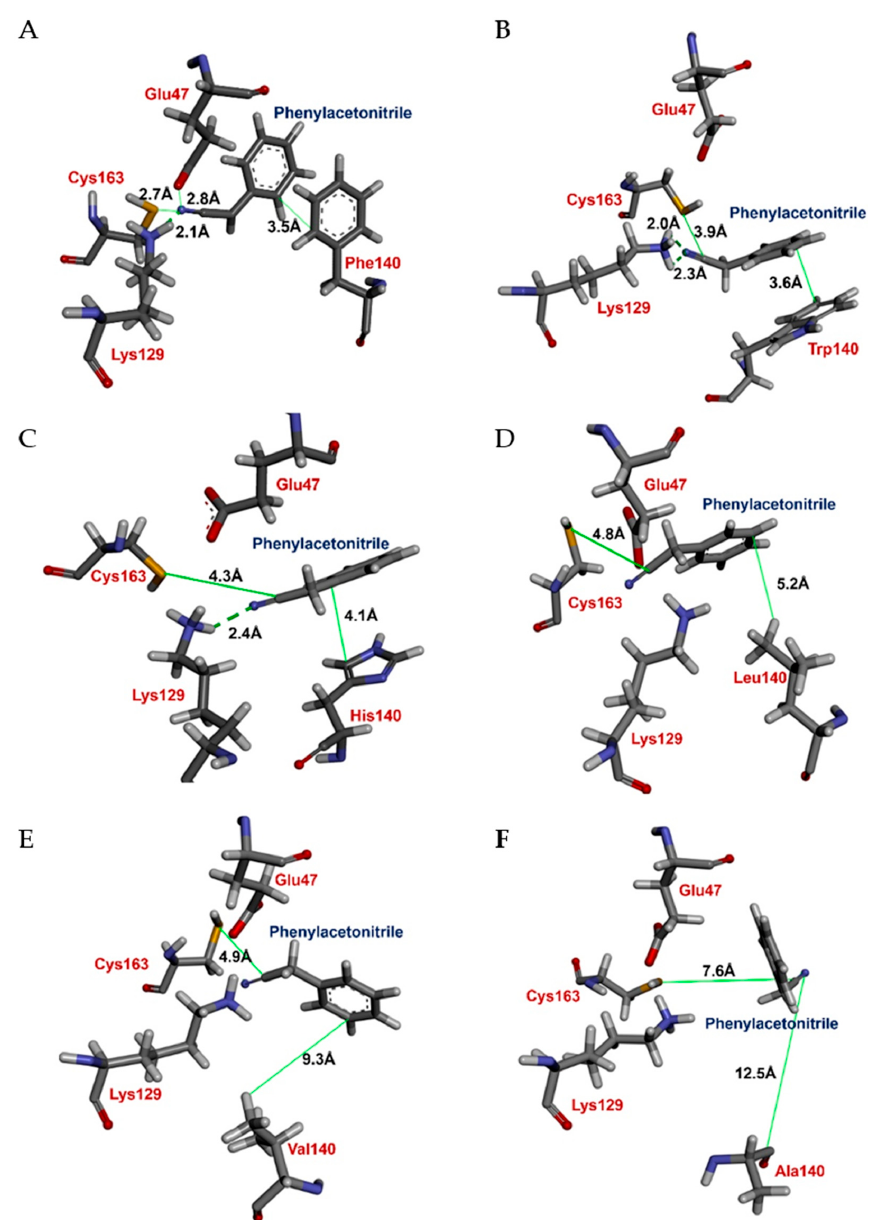
Figure 6. Model image of the NitAF active site. Phenylacetonitrile was docked into the substrate-binding pocket (SBP) of the ( A ) wild-type NitAF, ( B ) F140W, ( C ) F140H, ( D ) F140L, ( E ) F140V, and ( F ) F140A mutants. The distances between Cys-163 and phenylacetonitrile in NitAF and the F140A mutant were 2.7 Å and 7.6 Å, respectively. The green dotted line represents the H-bond, and the green straight line indicates the distance between the substrate and neighbor amino acid residues. Amino acids are shown as stick models.